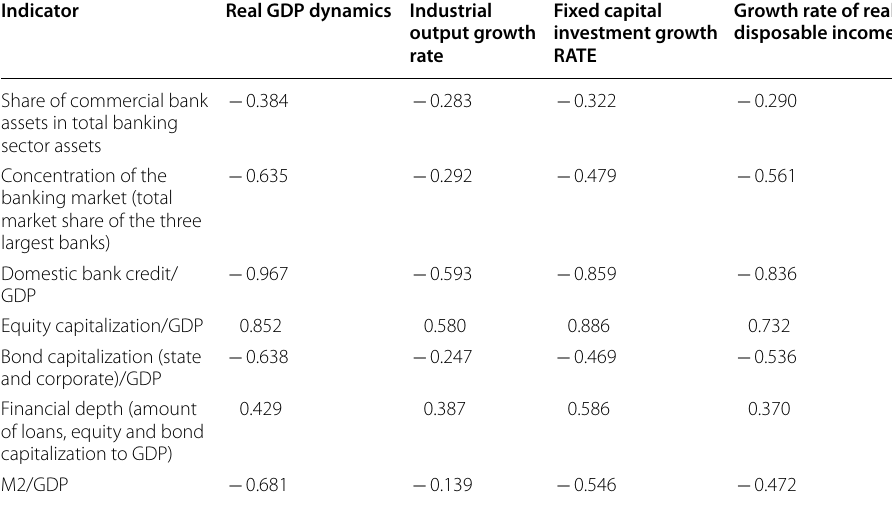
Table 2 Correlation coefficients between the main macroeconomic indicators and indicators